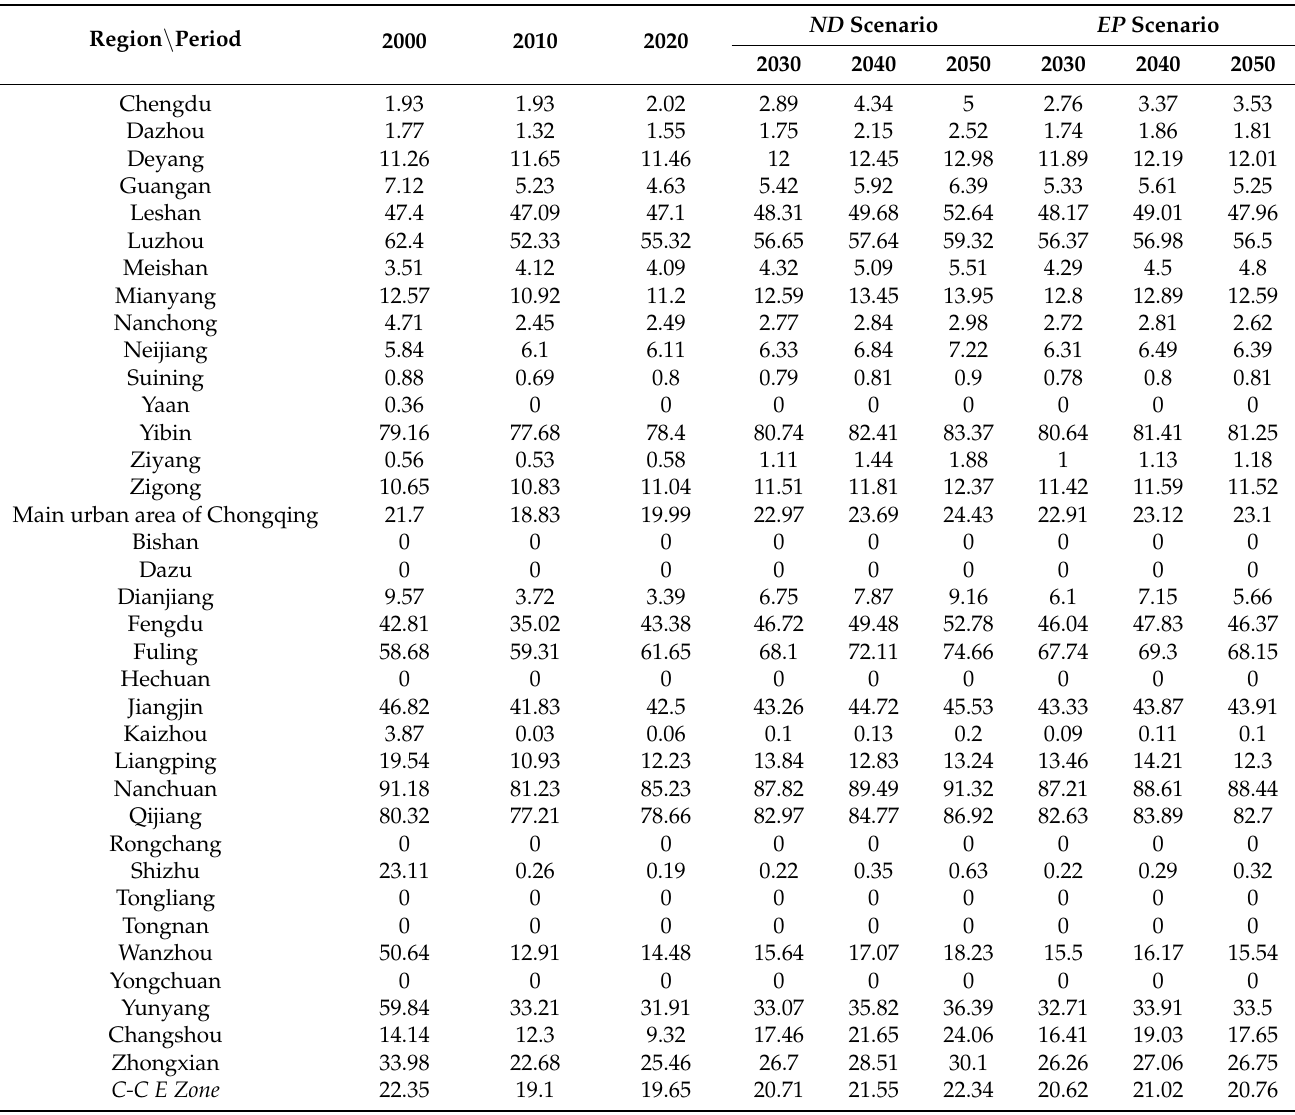
Table 3. Statistical table of high and extremely high risk proportions of LER in each